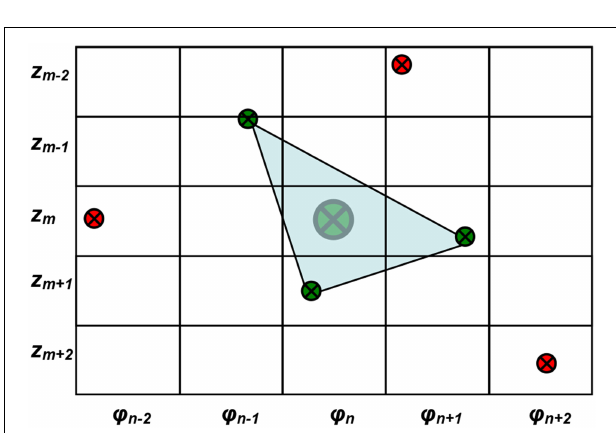
FIGURE 3 | Demonstration of the equally spaced ϕ and z grid and the method of interpolation of r for each grid. The large green dot denotes the desired interpolated surface contour data for ϕ n - z m grid. The small green dots are the three boundary data points closest to the ϕ n - z m grid. The red dots are boundary data points that are not selected for the